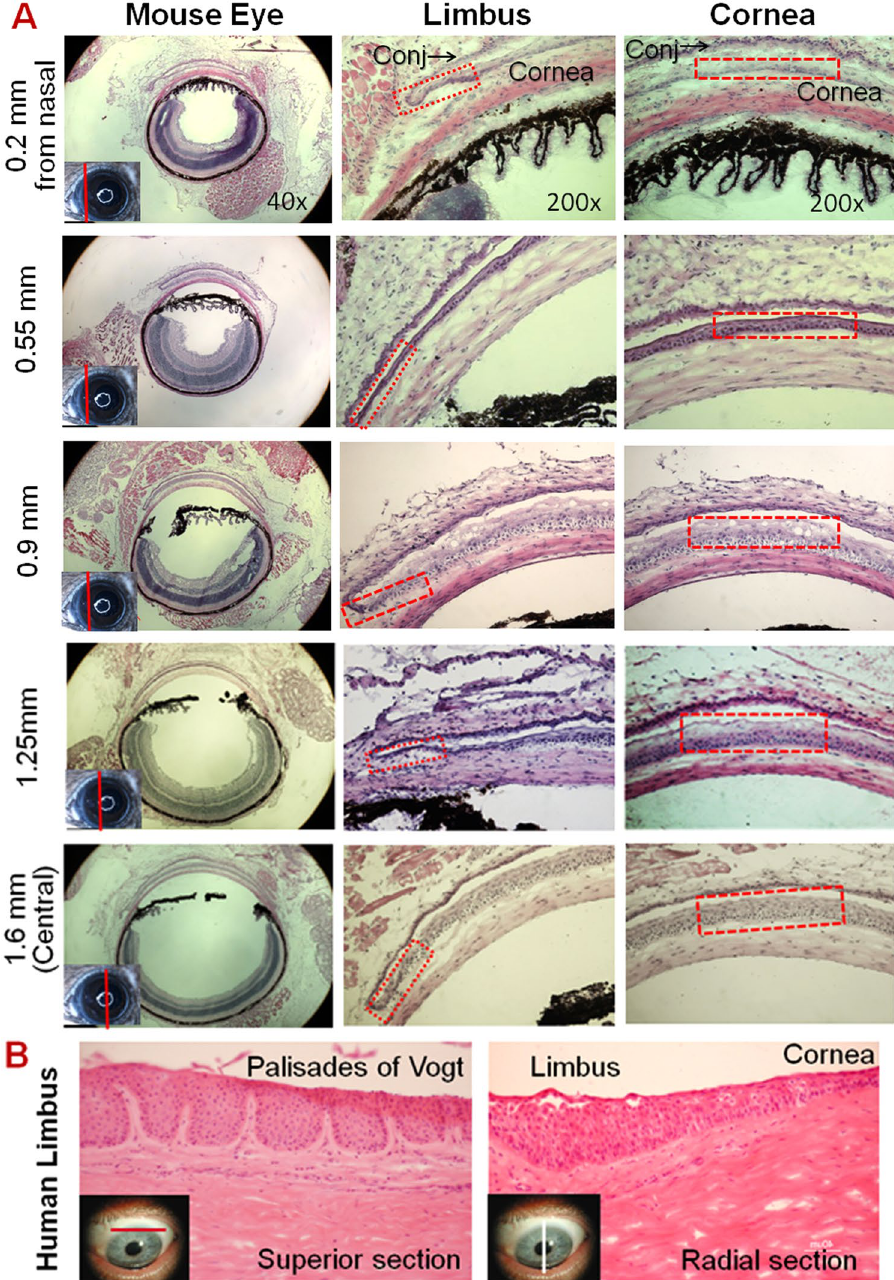
Figure 1. Representative Haematoxylin-Eosin (H & E) staining images of mouse and human corneas. ( A ) Five sets of images were chosen from a series of mouse corneal cross sections from nasal to central cutting. The left column shows images of whole eye sections at different positions as red line on small eye inserts. The middle column shows limbal structures with red rectangles indicating the limbal epithelium containing 1~3 layers of cells. The right column shows corneal structures with red rectangles indicating the 5–7 layers of central corneal epithelium. ( B ) Human limbal sections with vertical or horizontal cutting show the palisades of Vogt